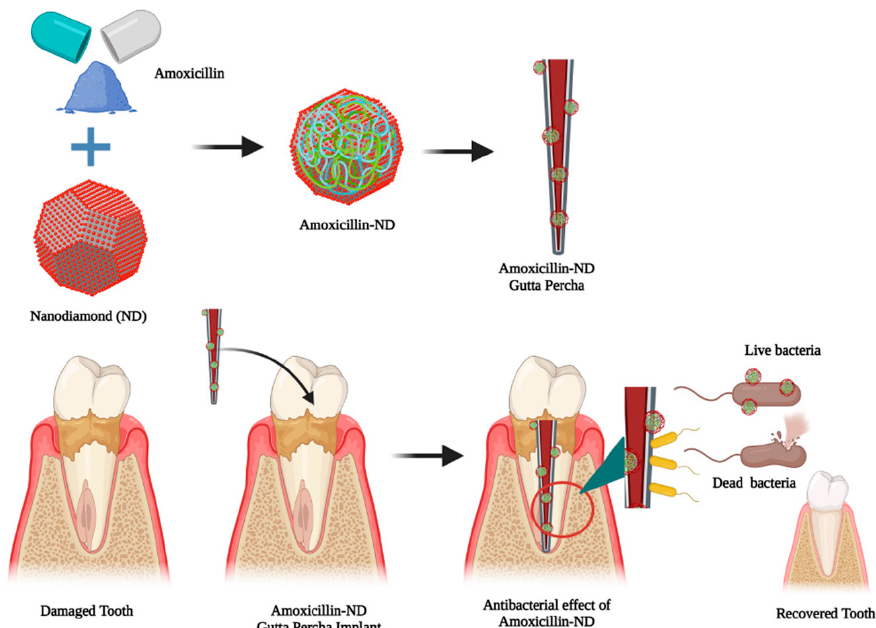
Figure 6. Nanodiamonds (NDs) used in the biological application of amoxicillin-ND aggregates imbedded in gutta-percha as a slow-release antibacterial agent.